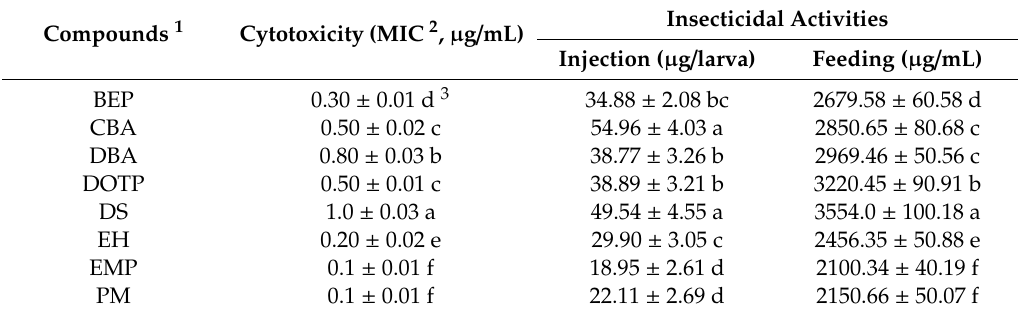
Table 3. Insecticidal activities of eight compounds identified from X. hominickii culture broth. Compounds 1 Cytotoxicity (MIC 2 , µ g / mL)